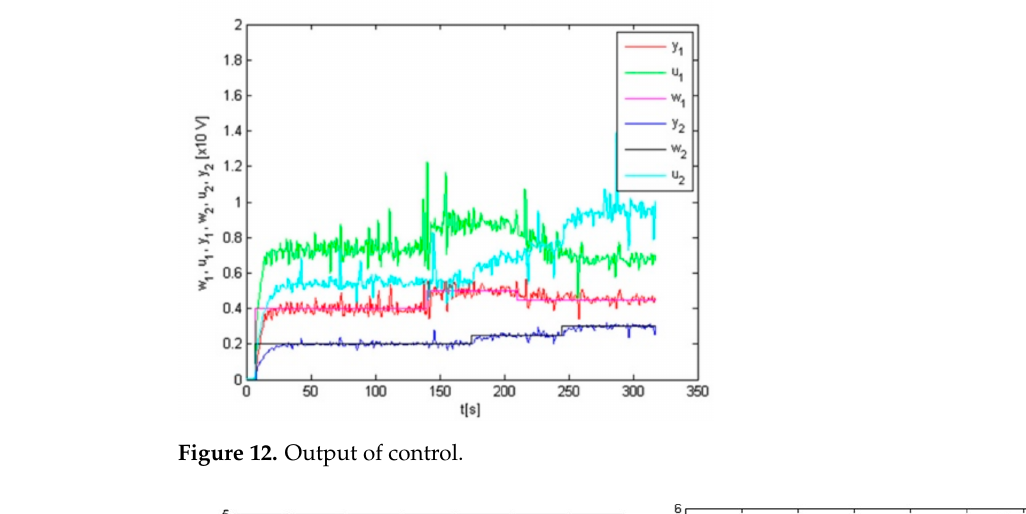
Figure 11. System pre-identification using recursive instrumental variable—1st subsystem ( left ),